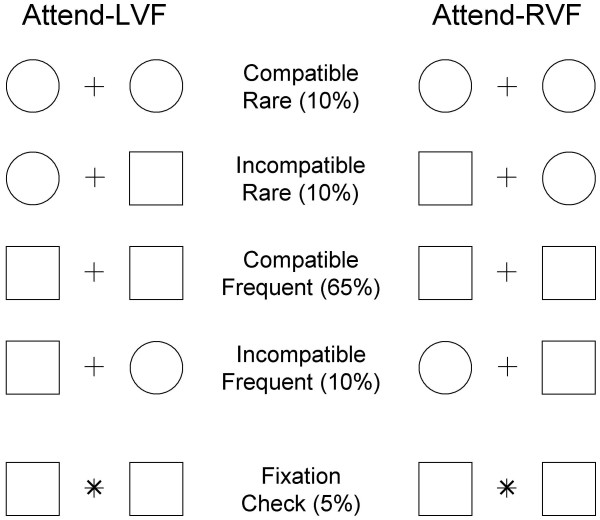
Stimulus arrays. The stimulus arrays in each attention condition are shown, along with the percentage of trials on which they were presented.